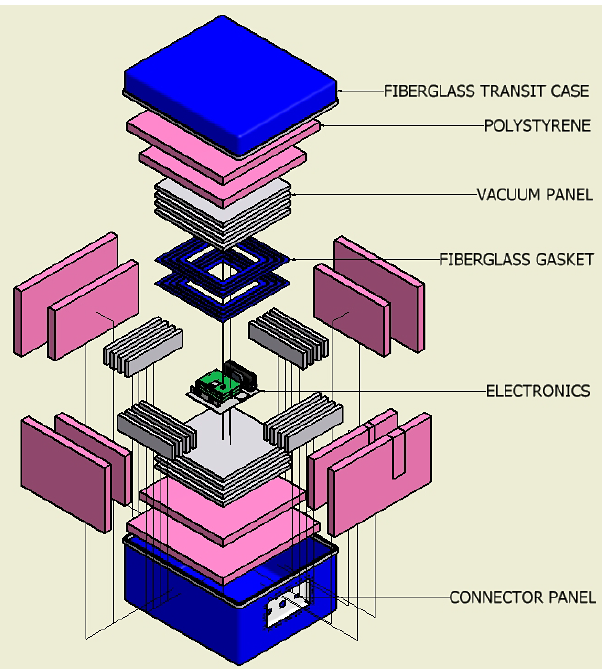
Figure 4. The super-insulated electronics box exploded view.